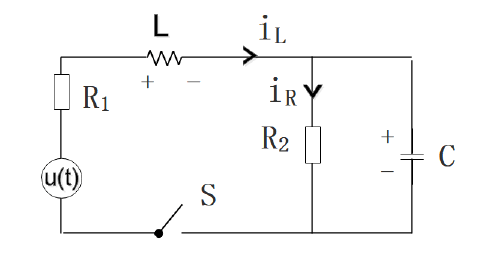
Figure 1. energy-storing electrical